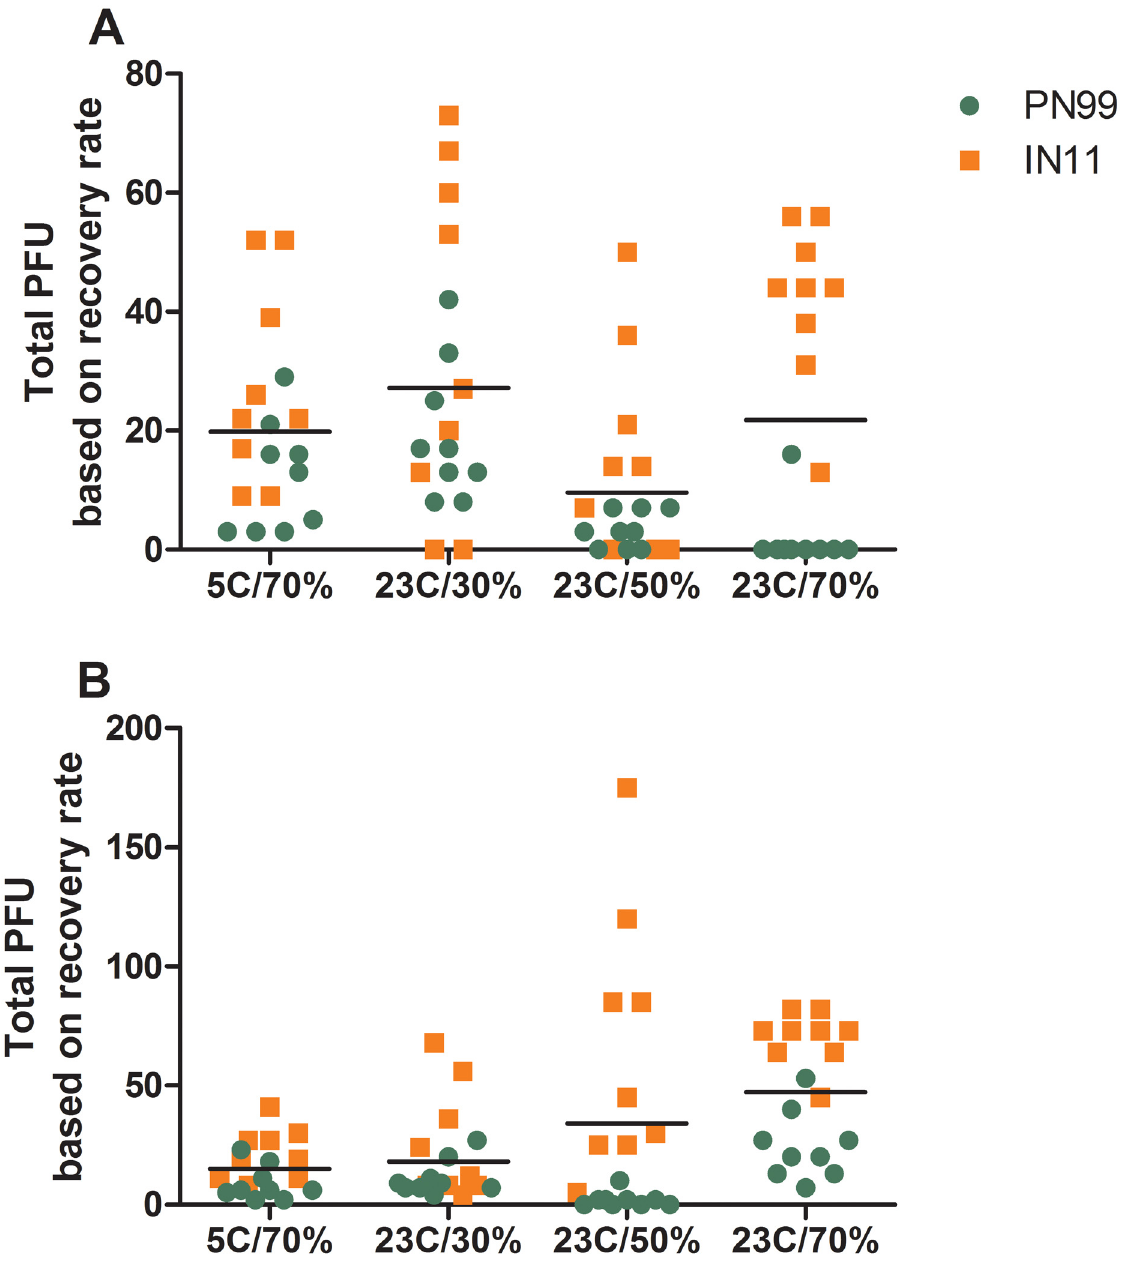
Fig 8. Influenza virus in aerosol samples exhaled by infected ferrets based on recovery rates. Three ferrets each were housed under the designated environmental conditions and were presented with 10 3.8 – 10 5.5 pfu of PN99 (green) or IN11 (orange) virus by aerosol inhalation. Aerosol samples were collected from ferrets on 1, 3, and 5 dpi for 15 minutes of normal breathing (A) and 5 minutes of sneezing stimulation (B). Total plaque forming units (pfu) collected from infected ferrets were normalized based on the recovery rates of known amounts of infectious virus using our aerosol collection procedure. Total pfu exhaled by infected ferrets in both size ranges combined and at each time point are presented. Each dot represents a single animal at a single time point. Scatter dot plots show the distribution of data with the horizontal line representing the grand mean for all samples collected under the designated